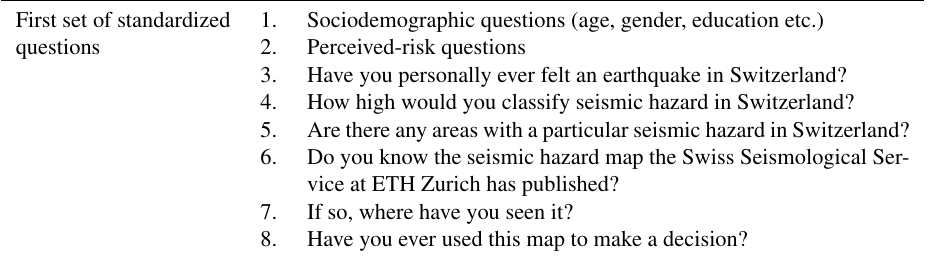
Table 1. First set of standardized questions. The public answered the questions online, and the workshop participants answered the questions on a handout. Translated from German to English by the authors.